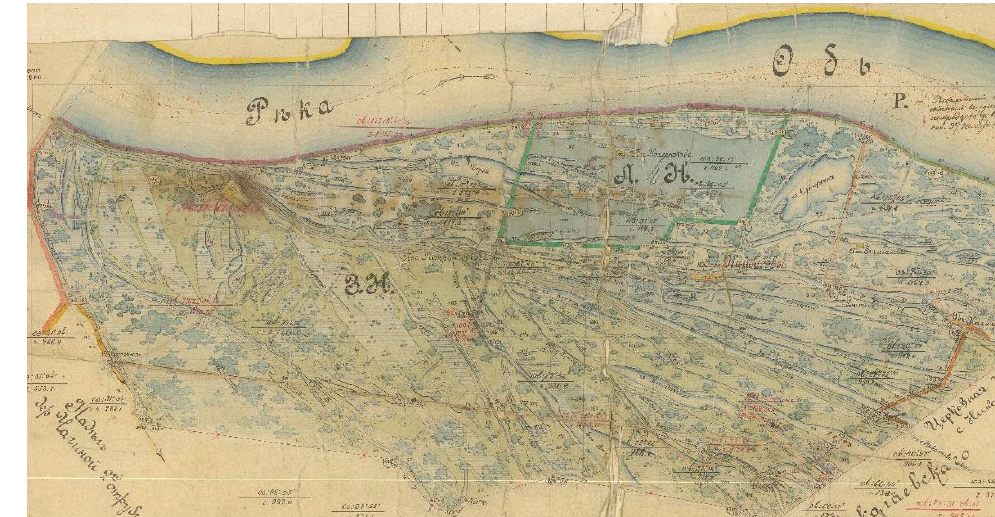
Figure A2. 1910 geometric plan of village of Kaibasovo.